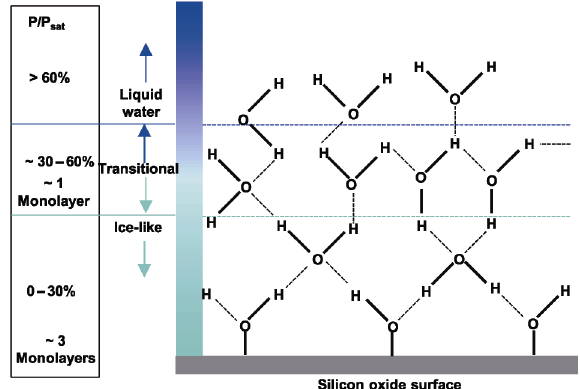
Fig. 3 Schematic of structural evolution of adsorbed water layer on hydrophilic silicon oxide surface. With the increase in RH, three regions with RH = 0–30%, ~30%– 60%, and RH > 60% are defined to demonstrate the different structures of adsorbed water layer on silicon oxide surface. Reproduced with permission from Ref. [61], © American Chemical Society